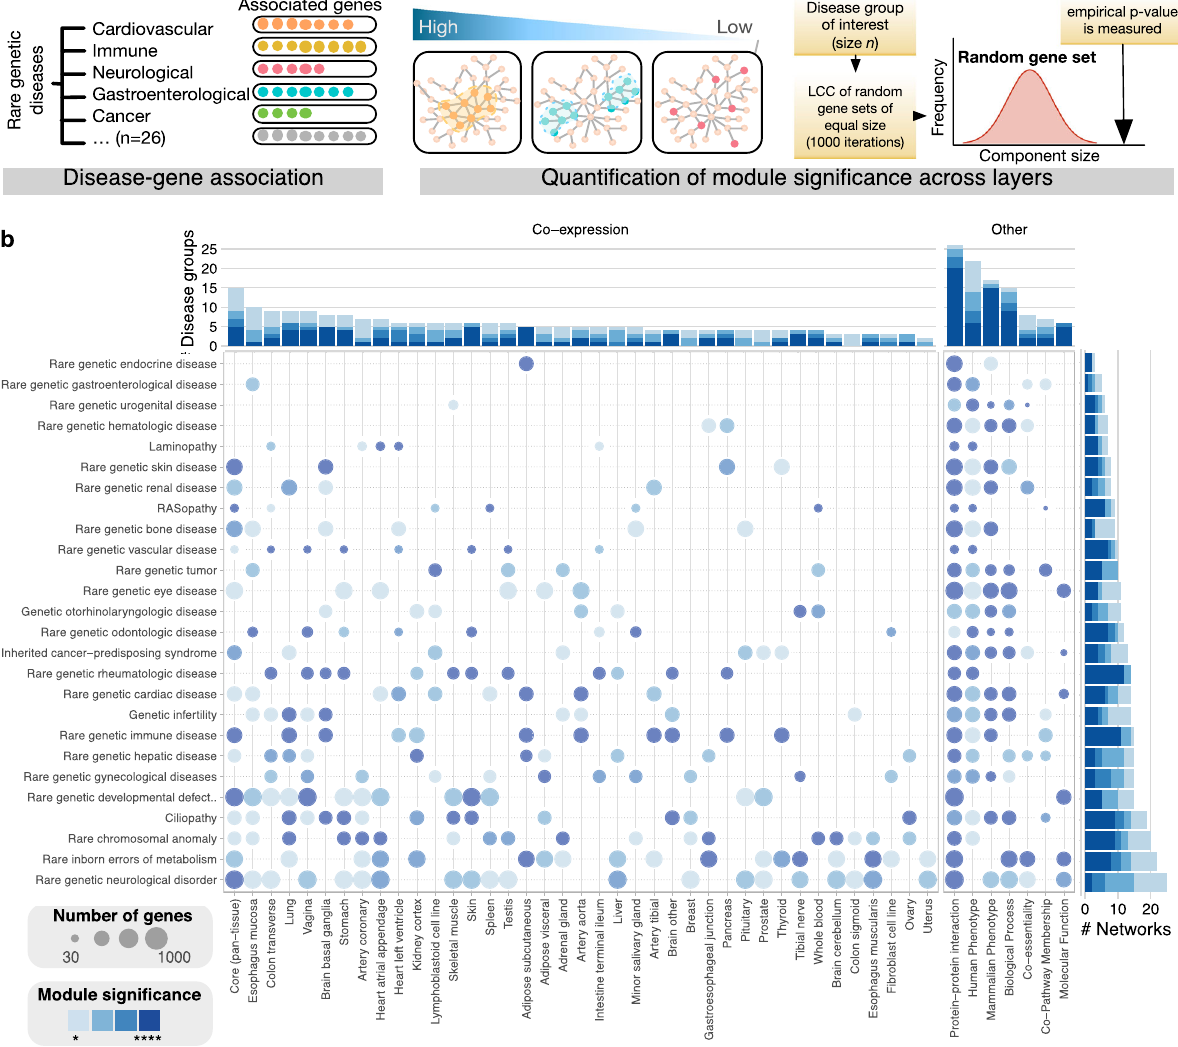
Fig. 3 Multiplex network modularity of rare disease groups. a Pipeline for disease module signi fi cance assessment. The size of the largest connected component (LCC) for genes associated with rare genetic disease groups collected from Fig. 2 were used to determine network relevance. b The heatmap shows the modularity of all rare disease groups across all network layers as measured by the respective module size signi fi cance ( p < 0.05: *, p < 0.01: **, p < 0.001: ***; p < 0.0001: ****, Benjamini – Hochberg corrected empirical p -values determined by node randomization, see Methods). In the tissue-speci fi c network layers, only selected disease groups display pronounced modularity, often recapitulating known mechanisms and tissue speci fi cities of particular rare diseases, but also revealing novel relationships. Network layers containing relationships that are relevant across biological levels of organization, such as protein – protein interaction, phenotypic and functional similarity networks, also display modularity across a wide range of disease Fig. 6a, b, Methods) enables us to interpret the disease char- phenotypic landscape observed in Fig. 2c corresponds to their acteristics within each layer: We found that genes causing the signi fi cant modularity across co-expression networks in a wide Bardet-Biedl syndrome (BBS) form pronounced clusters in the range of tissues, which, in turn, re fl ects the often syndromic and phenotypic and PPI layers. Together with the absence of mod- heterogeneous phenotypes of these diseases. ularity in other layers, this pinpoints that the emergence of this particular disease phenotype is mainly determined by interactions Using differential modularity to contextualize rare disease gene at the protein level, while co-essential, functional or pathway clusters . The individual layers within the cross-scale network levels play less important roles. This observation is supported by capture different pathobiological mechanisms. The observed dif- our current knowledge of BBS pathological mechanisms: The proteins encoded by BBS genes form a complex crucial for etiology speci fi c to a particular layer. For example, rare genetic transporting vesicles to cilia, a process whose defect is suspected to be a major cause of BBS 31 . At the same time, these proteins are of diverse functional character 32 and involved in disparate pathways 33 , explaining the lower modularity on the respective network layers.